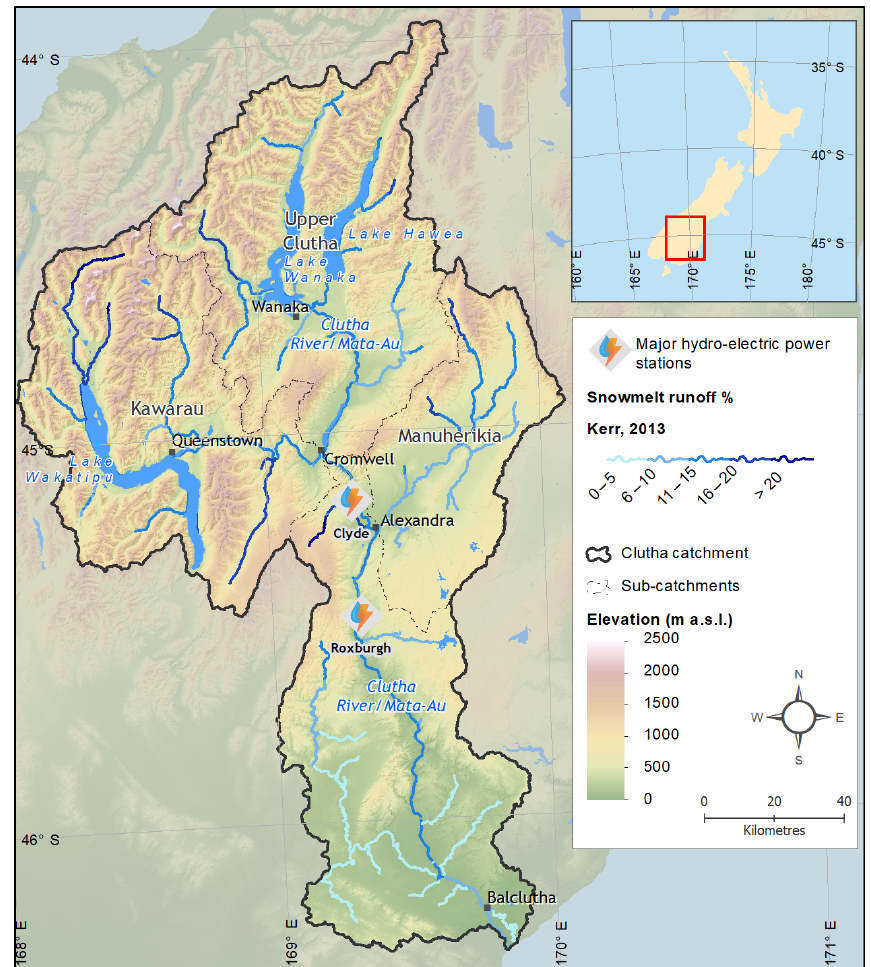
Figure 1. Context map of the Clutha Catchment, including snowmelt contribution to streamflow for rivers of stream order 4 and greater, and snowmelt contribution data from Kerr (2013). The boundaries of the Upper Clutha, Kawarau and Manuherikia sub-catchments are also included. Elevation and relief data from Columbus et al. (2011); lake outlines and geographic place names are sourced from the LINZ Topographic Database and stream network and catchment boundaries from MfE River Environments Classification (Snelder et al.,